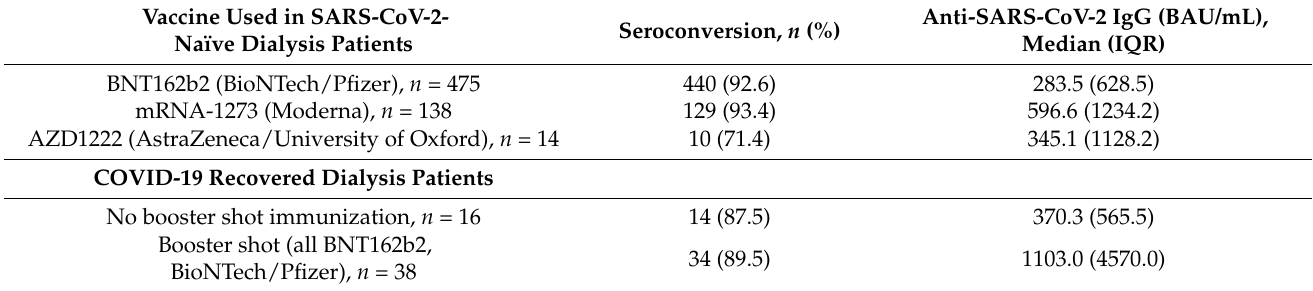
Table 1. Seroconversion and anti-SARS-CoV-2 IgG titer as determined by anti-SARS-CoV-2 serology in dialysis patients vaccinated with BNT162b2 (BioNTech/Pfizer), mRNA-1273 (Moderna), or AZD1222 (AstraZeneca/University of Oxford) and in COVID-19-recovered dialysis patients with/without BNT162b2 booster shot immunization. COVID-19: coronavirus disease 2019; SARS-CoV-2: severe acute respiratory syndrome coronavirus type